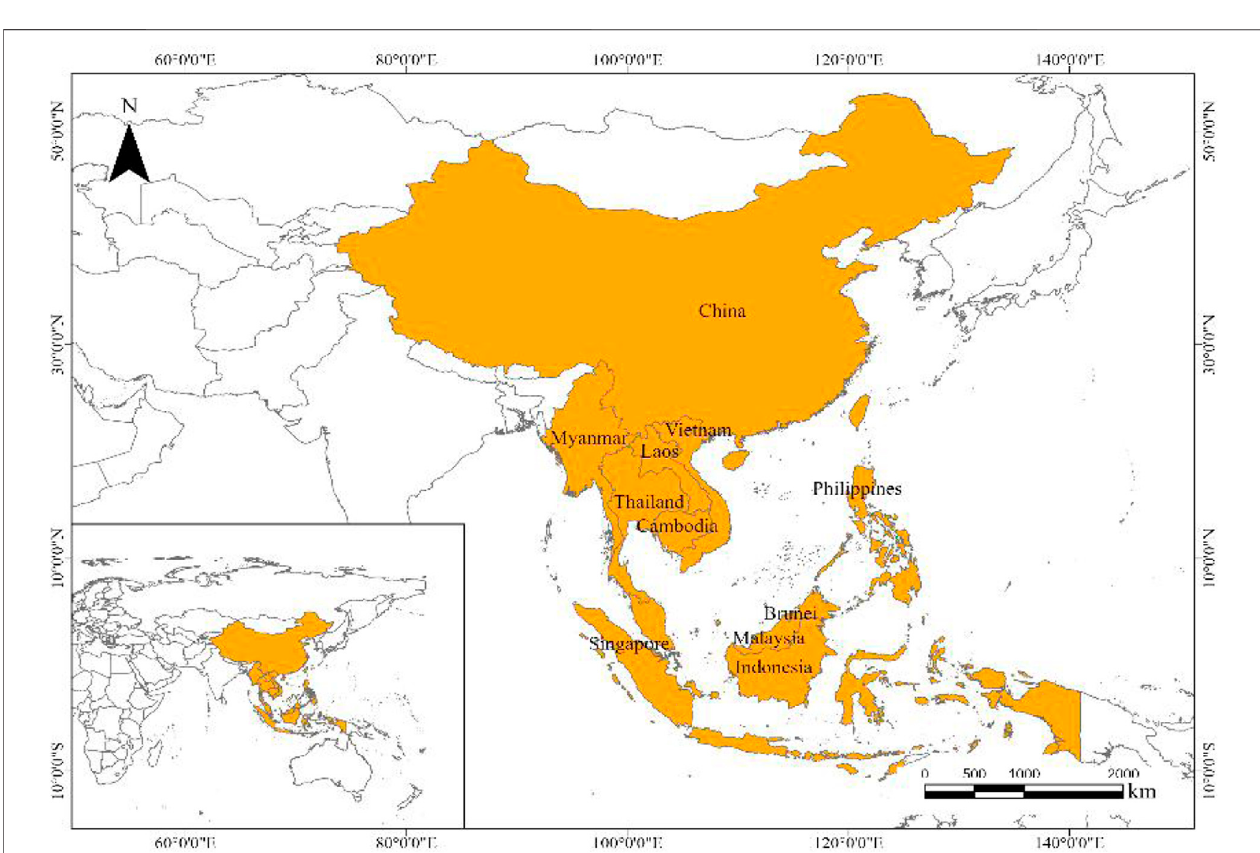
FIGURE 2 | Geographical location of the study area and the 11 countries along the B&R route.